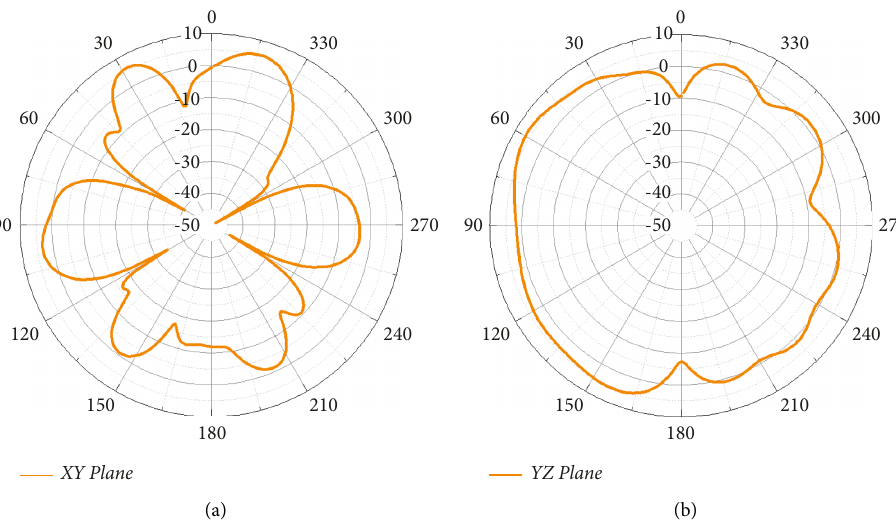
Figure 29: 2D radiation patterns (2 × 2 Array) on (a) XY plane and (b) YZ plane.